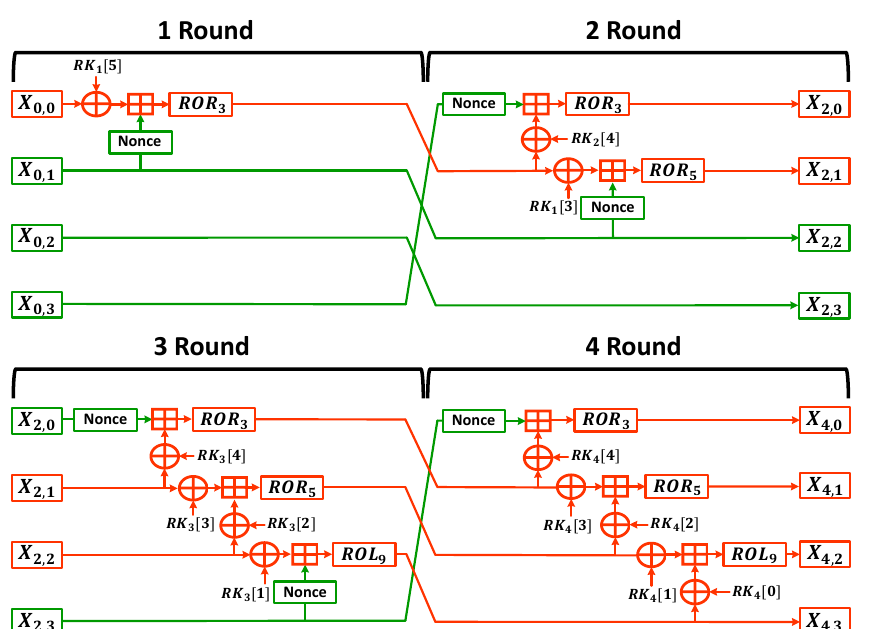
Figure 11. Proposed LEA-CTR mode optimization through pre-computation for the initial four rounds.